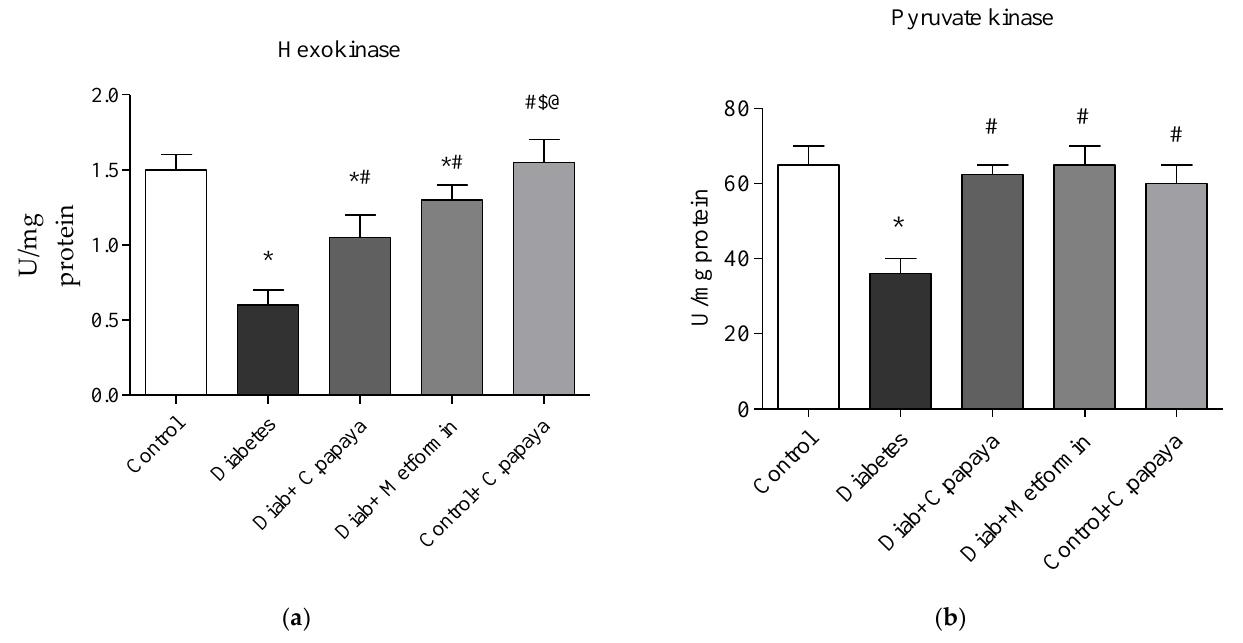
Figure 4. ( a , b ) Efficacy of C. papaya on ( a ) HK and ( b ) PK levels. p < 0.05 was considered statistically significant among the groups: *-control; #-diabetes; $- C. papaya -treated T2DM; @-T2DM rats + Metformin-treated T2DM.